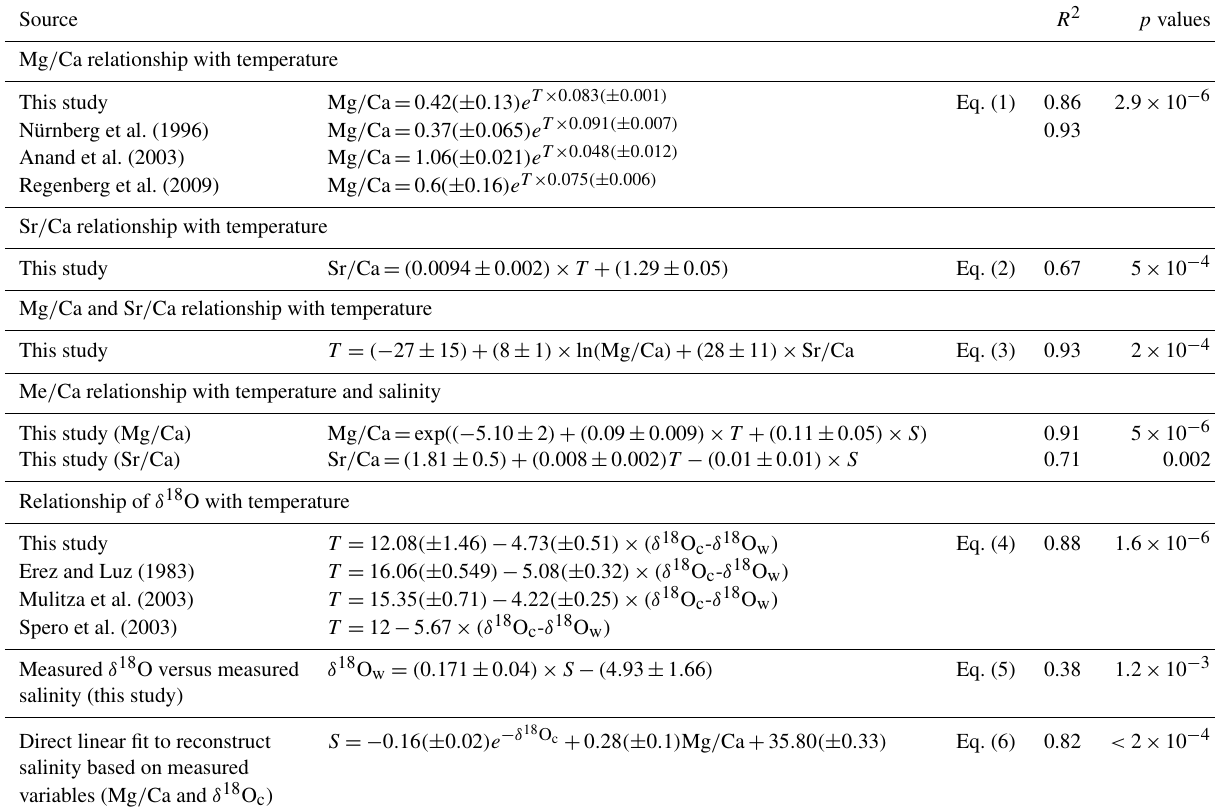
Table 3. Calibration equations for T. sacculifer